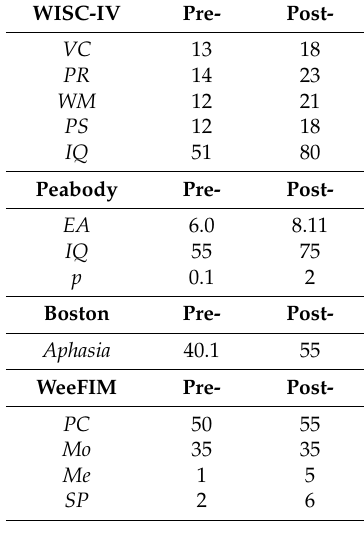
Table 1. Scores obtained in the different areas of stimulation, at admission (Pre-) and before discharge (Post-). Neurostimulation (WISC-IV test): VC = verbal comprehension; PR = perceptual reasoning; WM = working memory; PS = processing speed; IQ = intelligence quotient score.